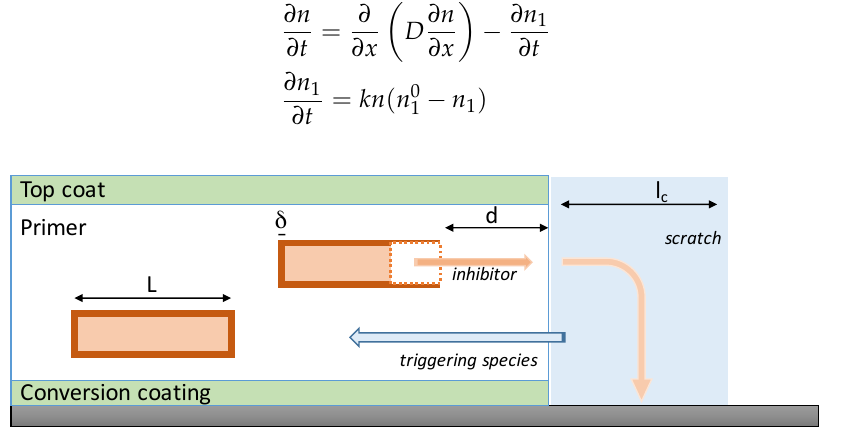
Figure 5. Schematic representation of the processes leading to the leaching of corrosion inhibitors from a damaged